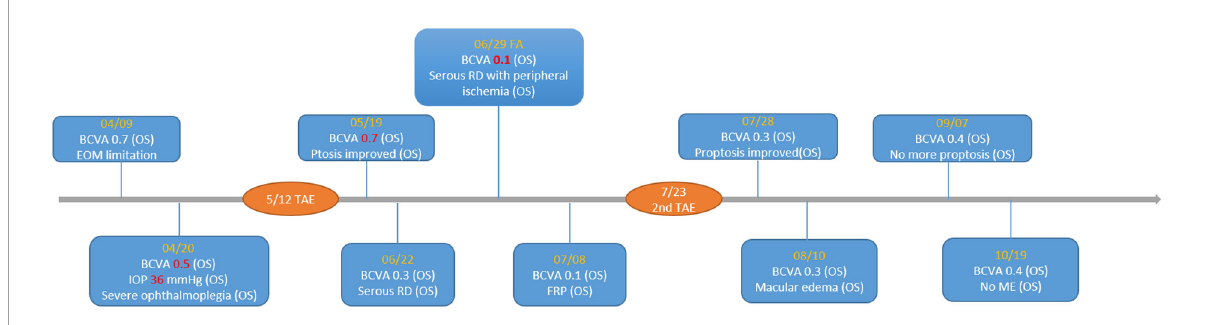
FIGURE6 Timeline of important visual acuity change. BCVA, best-corrected visual acuity; RD, retinal detachment; FRP, focal retinal photocoagulation; ME, macular edema; TAE, transarterial